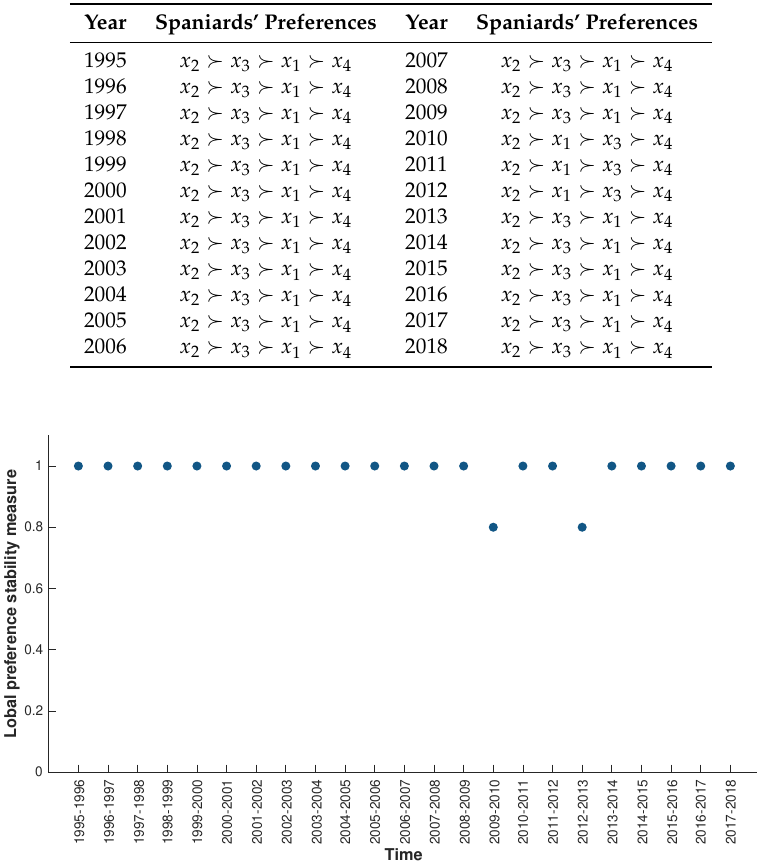
Figure A1. Graphic illustration of the local decision stability measures obtained for the entire society for Question